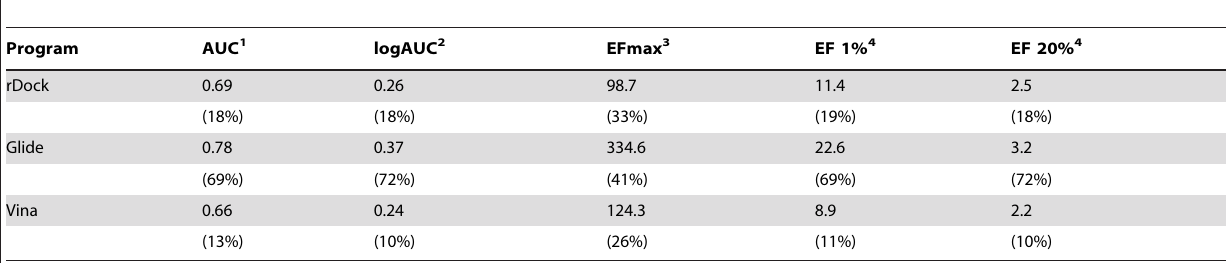
Table 3. Average values of different VS performance metrics over the 39 DUD/DUD-E